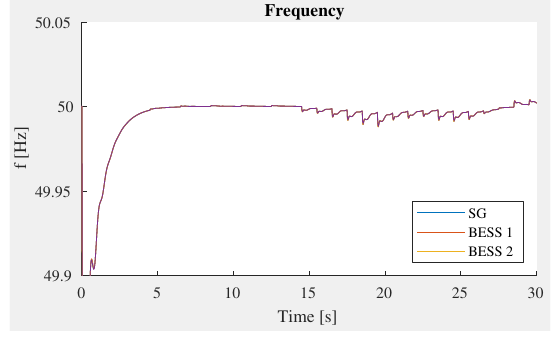
Figure 15. Frequency.